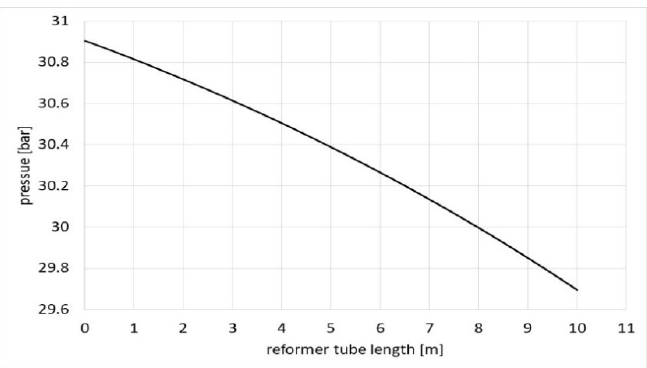
Figure 10. Calculated pressure drop profile along the reformer tubes at given process conditions.